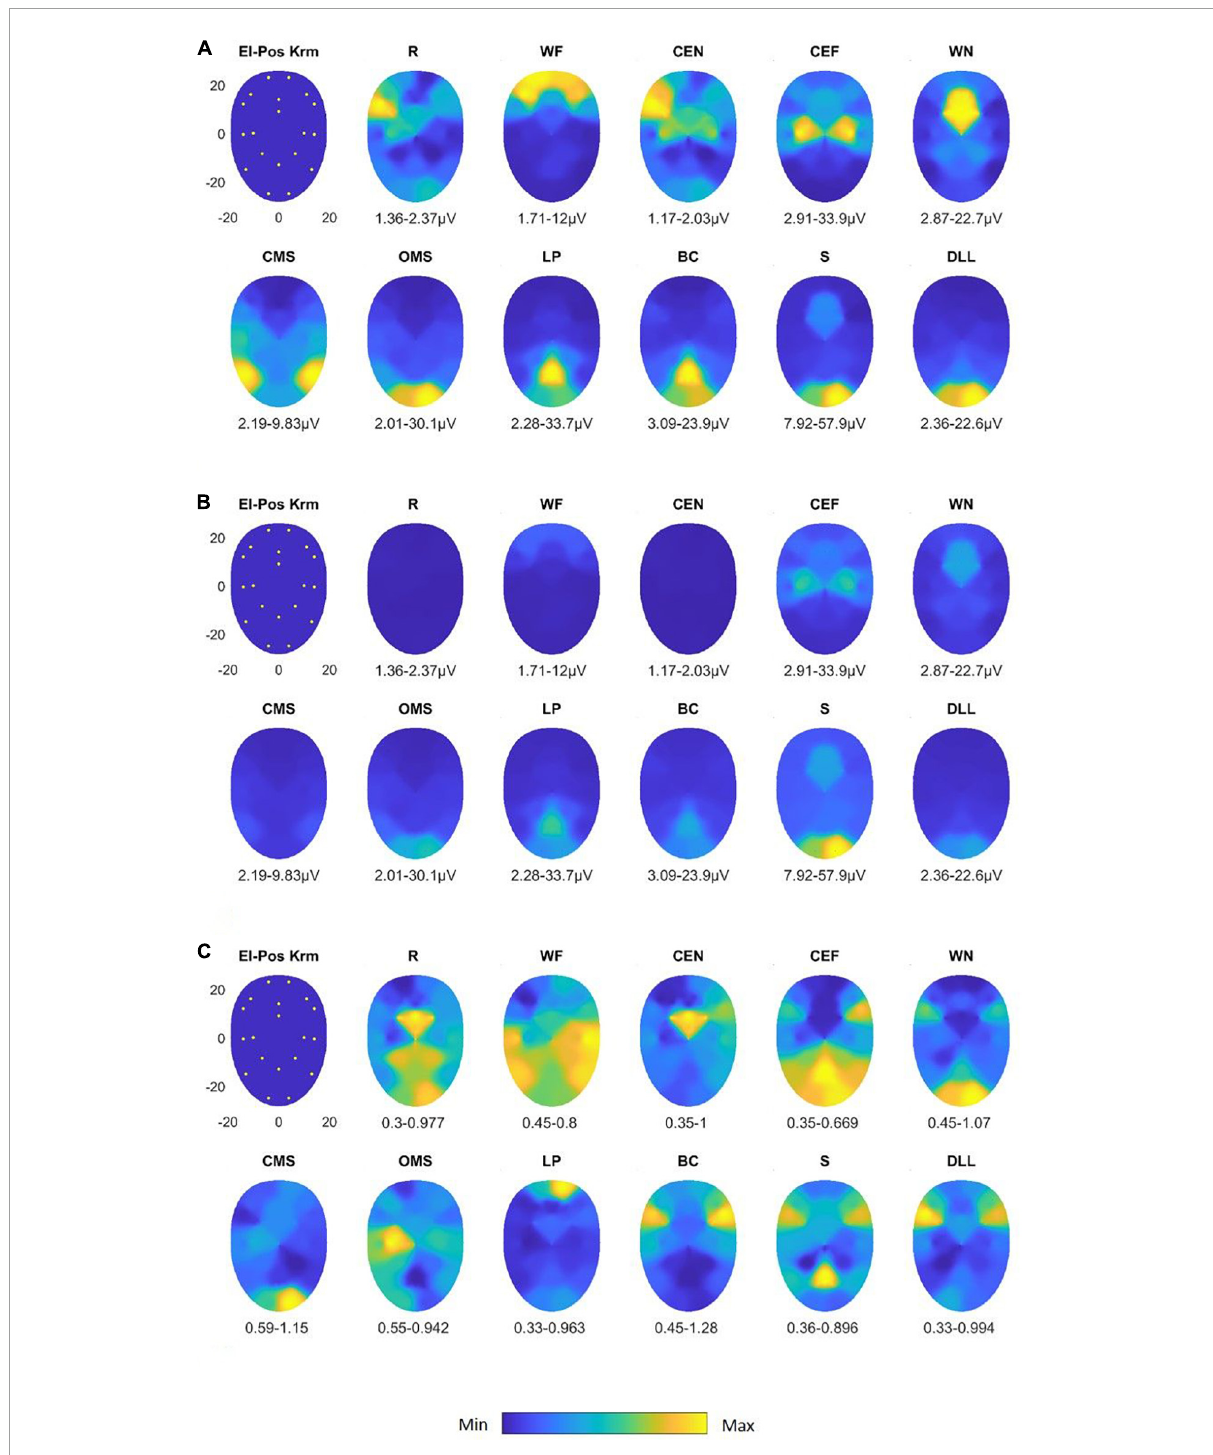
FIGURE5 Activation heat maps of facial muscle activity during different mimic exercises using the Kuramoto scheme (El-Pos Krm). According to the provided color bars, blue stands for low values and yellow for high values. Below each map, the respective minimal (Min) and maximal (Max) are provided. (A) Heat maps with always individual Min to Max scaling; (B) heat maps scaled according to the Min and Max values across all facial movements. (C) Variability (variation coefficient) heat maps. R, at rest; WF, wrinkling of the forehead; CEF, closing the eyes normally; CEF, closing the eyes forcefully; WN, wrinkling of the nose; CMS, closed mouth smiling; OMS, open mouth smiling; LP, lip puckering; BC, blowing-out the cheeks; S, snarling; DLL, depressing lower